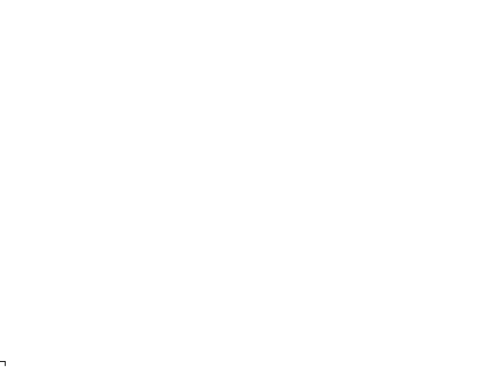
Figure 7. HKs and HCECs viability on the hybrid constructs. The scale bar is 500 μ m.